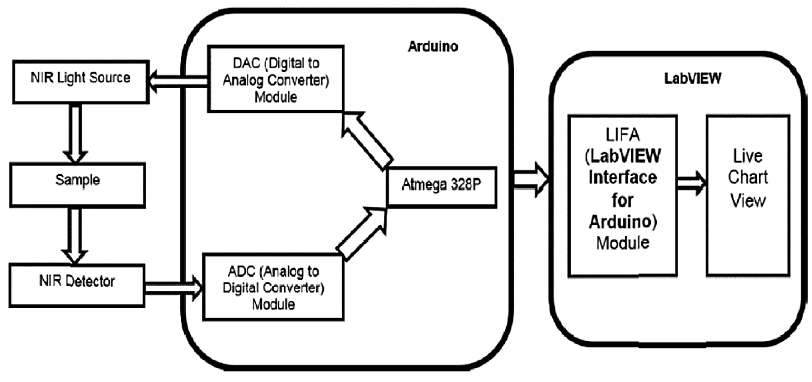
Figure 6. Block diagram of the non-invasive glucose monitoring system proposed in [33].